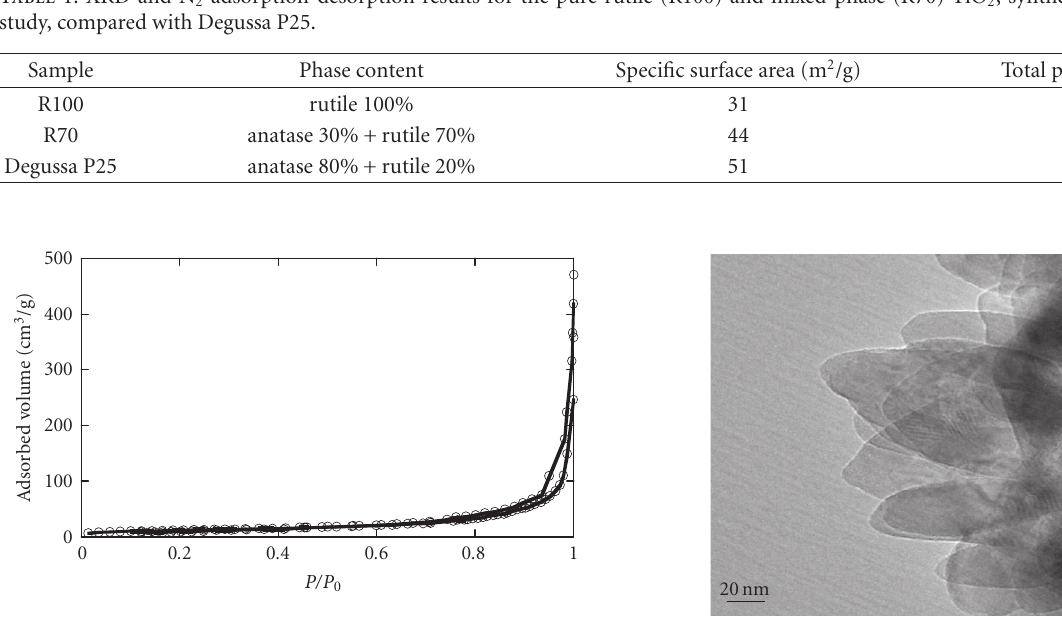
Figure 5: High-resolution transmission electron micrograph of the R100 TiO 2 catalyst.